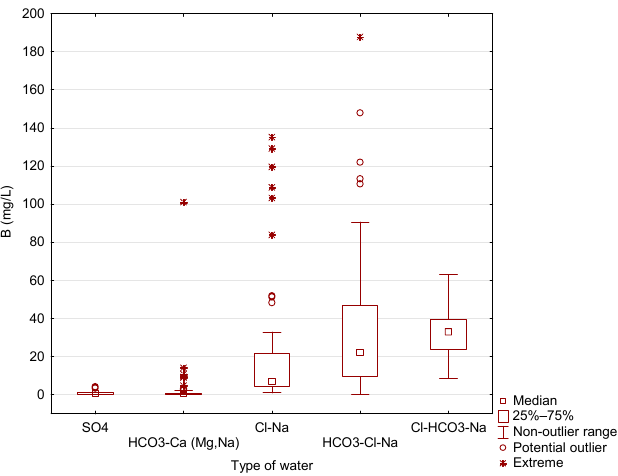
Figure 4. Boxplot of boron concentration in curative water in Poland. Correlation analyses were performed for the concentrations of TDS and major ions (Na + , Ca 2+ , Mg 2+ , Cl − , SO 42 − , CO 32 − and HCO 3 − ) in relation to boron concentration, covering two aspects simultaneously, i.e., analysis of the graphical point distributions, and calculation the linear correlation coefficients. Boron concentration versus the sum of dissolved solids (mineralization of water) is shown in Figure 5. This relationship is presented both on a linear and logarithmic scale. The linear correlation coefficient for Cl-HCO 3 -Na type waters is 0.67 (less than 0.7), and the graphical distribution of points may indicate the linear relationship between boron content and mineralization (Figure 5). However, the dataset contains a small amount of data (N = 16) and it is difficult to draw general conclusions. In the case of waters of the HCO 3 -Cl-Na type, almost a full correlation between boron concentration and mineralization of water is observed (Table 3, Figure 5). This correlation (r > 0.7) is not seen in the case of other types of water. In HCO 3 -Cl-Na type waters, there is also a linear correlation between the boron concentration and the concentration of HCO 3 − and Na + ions, and the linear correlation coefficients are 0.95 and 0.91, respectively (Figure 5). The value of the Pearson’s correlation coefficient in the case of other correlations was below 0.7 (r < 0.7). The chemical composition of the analyzed water is presented in Figure 6 (Piper diagram). Boron in concentrations above 25 mg/L occurs only in sodium chloride and sodium bicarbonate waters. In this type of water, boron is present in various concentrations. Nevertheless, most waters of this type are characterized by concentrations above 5 mg/L. It should also be noted that in waters with a high boron concentration, sodium dominates among the cations (present in an amount above 80% milivals—left triangle in the diagram), while among the anions, chlorides occur in various concentrations (from over 20% milivals to over 99%—right triangle of the diagram). Boron in concentrations above 5 mg/L is not present in waters of magnesium chloride and calcium bicarbonate